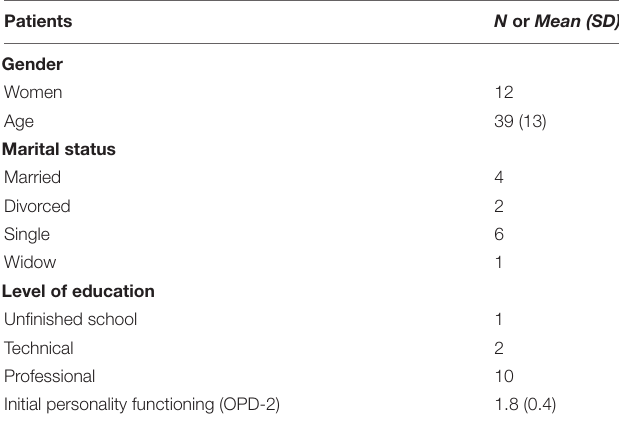
TABLE 1 | Patients’ descriptive statistics ( N =